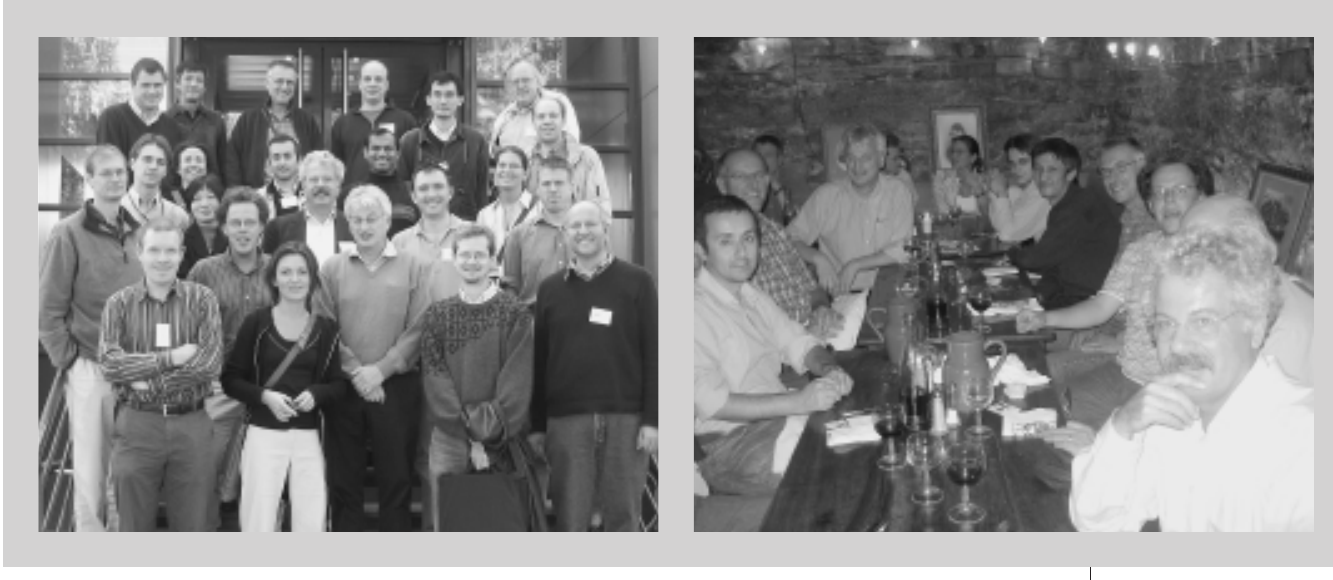
Figure 1 (left): The workshop participants at CECAM. Figure 2: Workshop participants sampling the cuisine